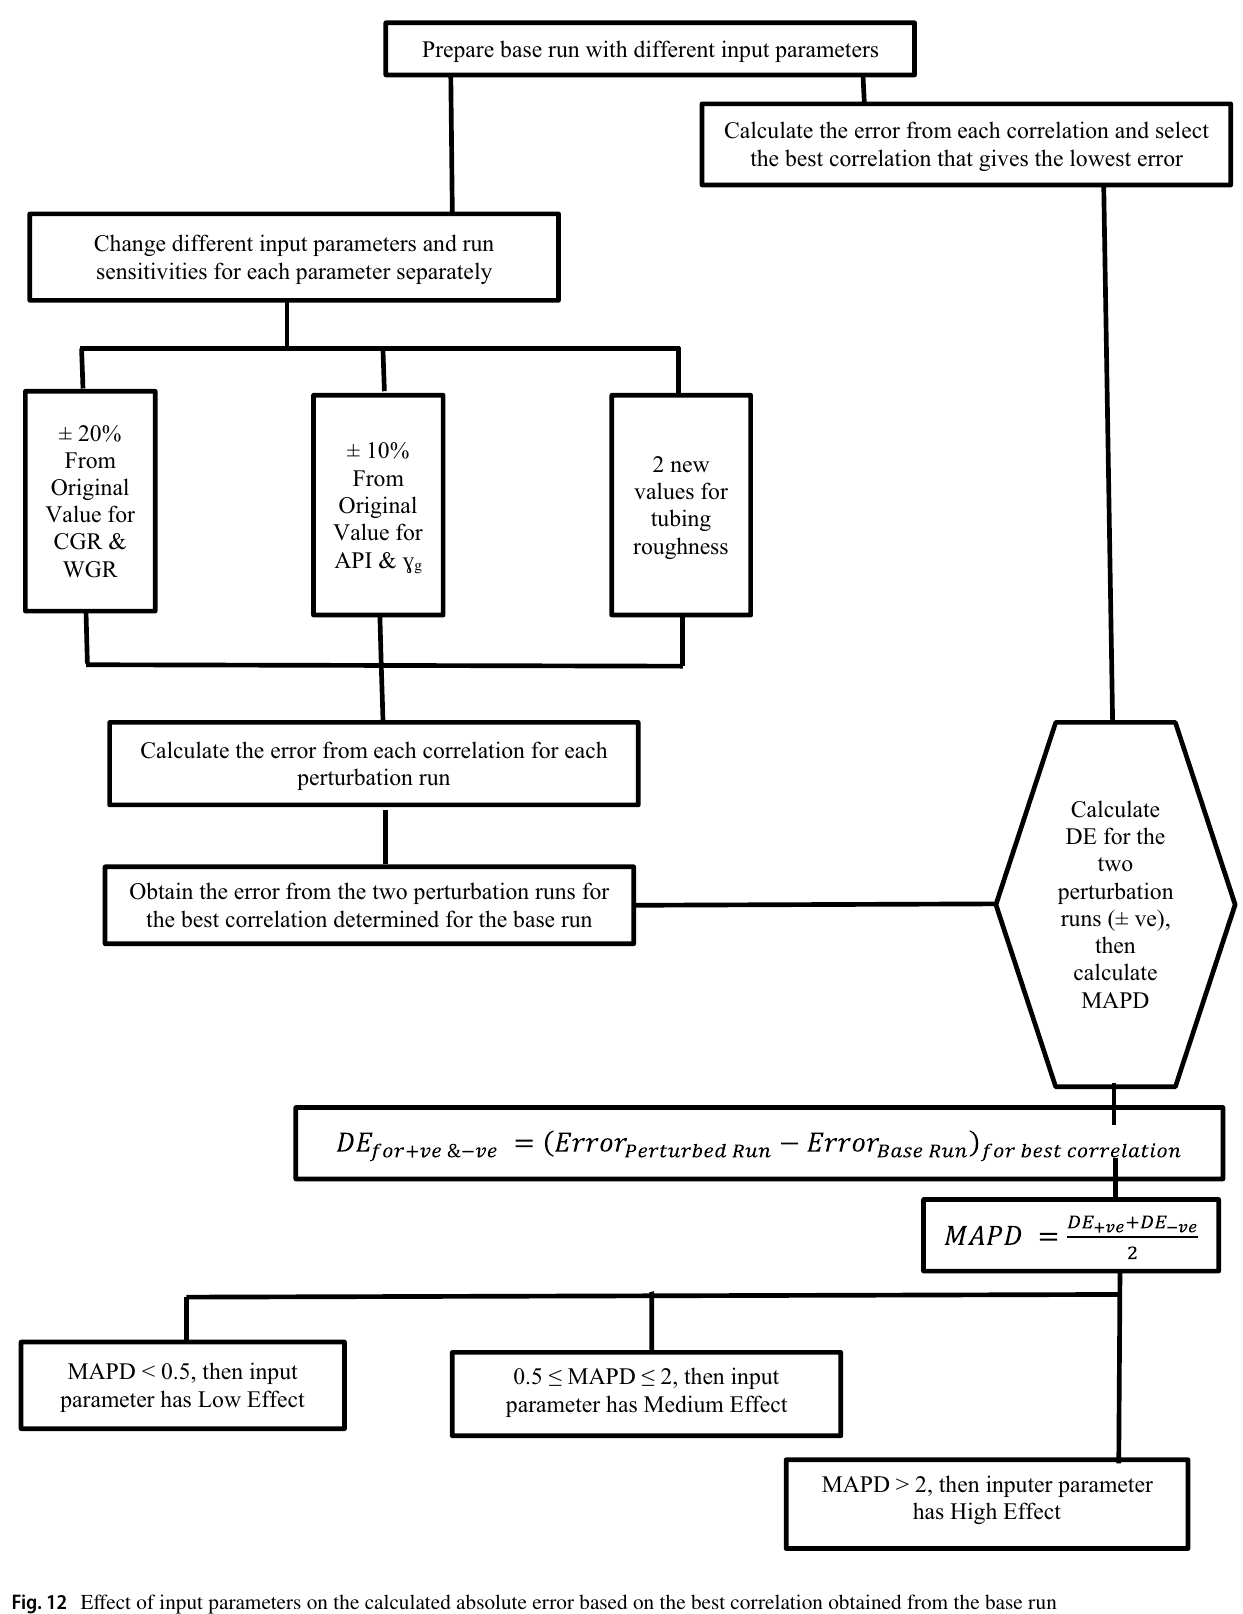
Fig. 12 Effect of input parameters on the calculated absolute error based on the best correlation obtained from the base